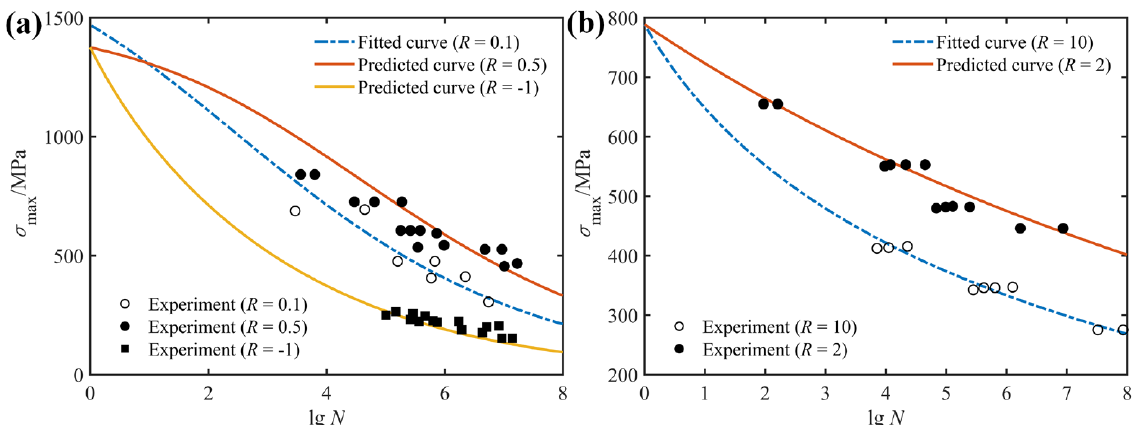
Figure 4. Fitted and predicted S - N curves of unidirectional glass/polyester [0°] 8 , along with experimental data from Ref. [31]: ( a ) Tension–tension and tension—compression fatigue; ( b ) compression–compression fatigue.